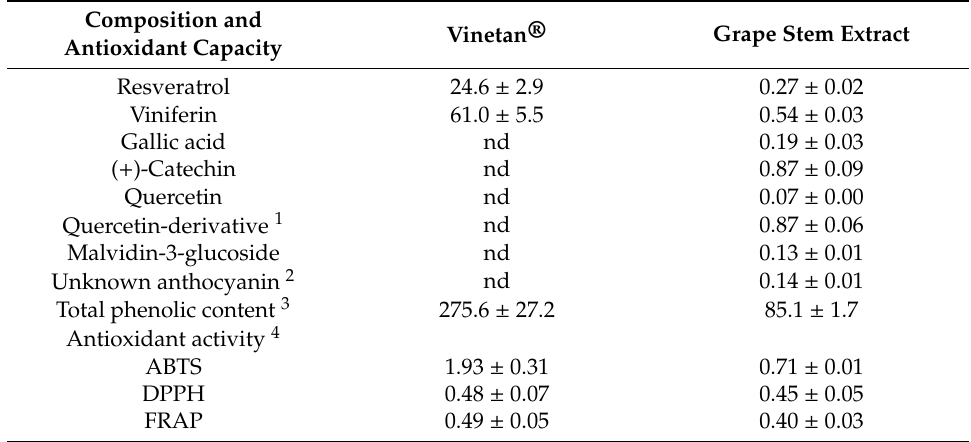
Table 1. Phenolic composition (mg / g extract) and antioxidant capacity of Vinetan ® and the Mazuelo stem extract used in this study (Mean ±